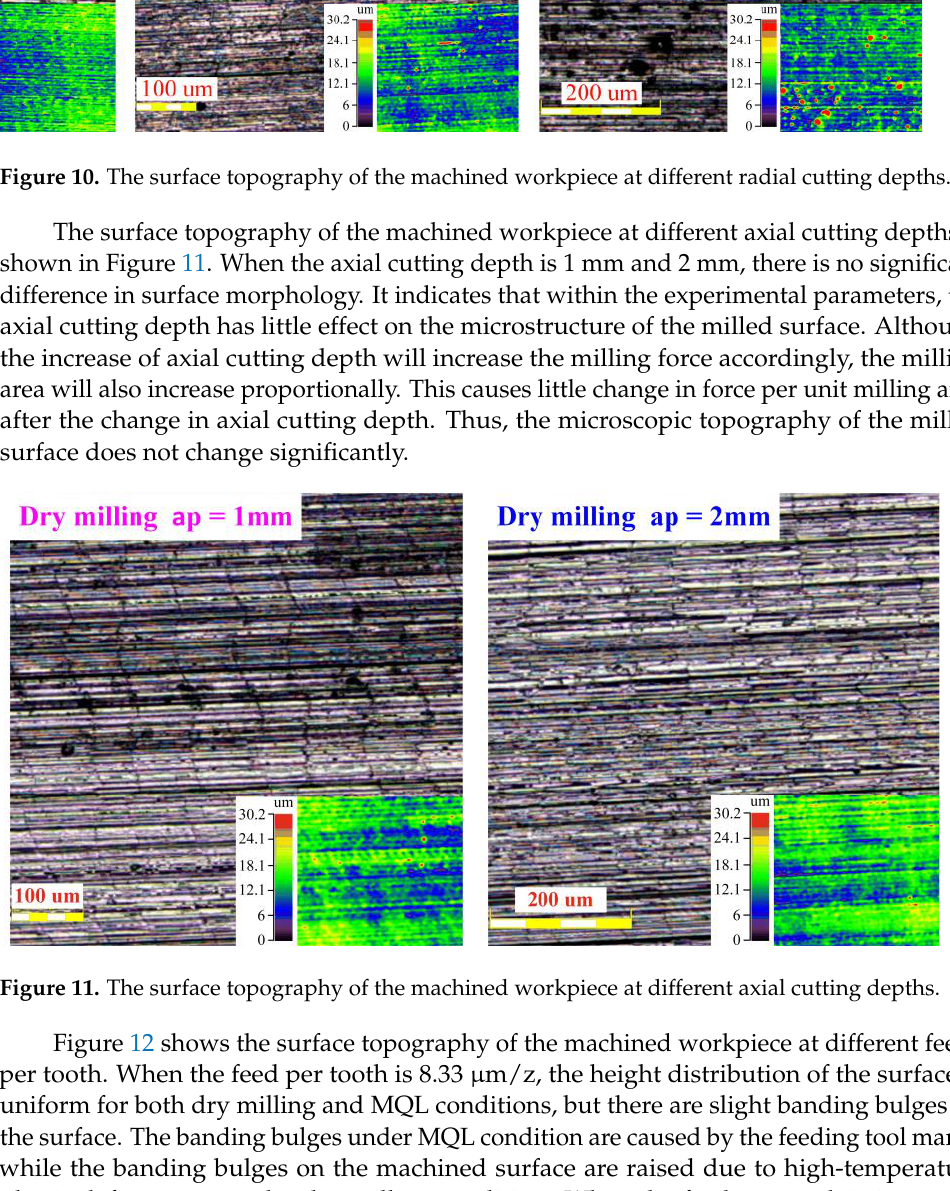
Figure 12. The surface topography of the machined workpiece at different feeds per tooth. 3.1.3. Effect of MQL on the Microscopic Topography of Milled Workpiece MQL is a green machining method that uses the high-pressure oil mist to cool and lubricate the machining area. The number and position settings of the high-pressure oil mist nozzles, air pressure, and lubrication amount used all affect the lubrication effect of MQL. Figure 13 shows the surface topography of the machined workpiece at different lubrication amounts. According to Figure 13, it can be seen that under MQL machining condition, when the lubrication amount is 40 mL/h, the feeding tool marks are more ob- vious compared to dry milling. Compared with the lubrication amount of 80 ml/h, there are more banding bulges on the bottom surface of slot milling, which is caused by plastic deformation. Thus, when the lubrication amount is 40 mL/h, it cannot improve the plastic deformation of the workpiece surface caused by the extrusion of cutting heat and tool flank. The cooling effect from the high-pressure oil mist makes feeding tool marks more obvious. The rational selection of MQL amount is of great significance. When the amount of lubricating oil is too small, not only can it not effectively improve the surface quality, but it can also make the surface quality deteriorate sharply. In MQL machining, there is a critical amount of lubricating oil. When the critical amount is reached, a stable lubricant